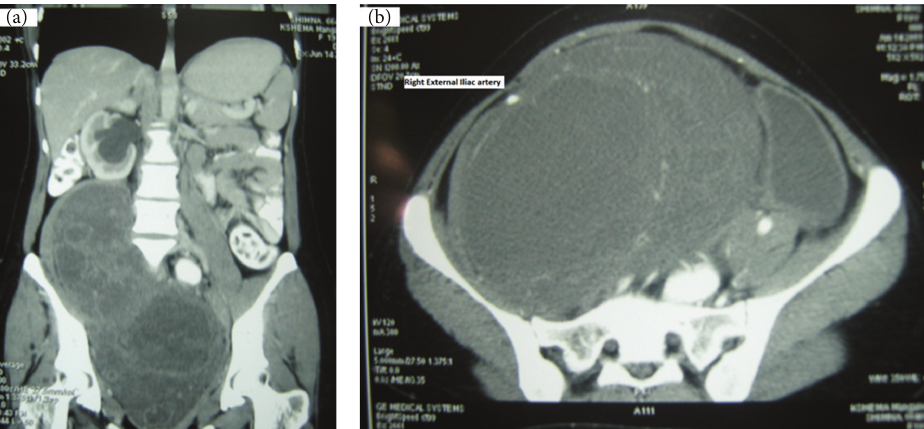
Figure 1: (a) C.T. scan showing large lobulated mass lesion in the pelvic retroperitoneum. (b) Right external iliac artery stretched over the